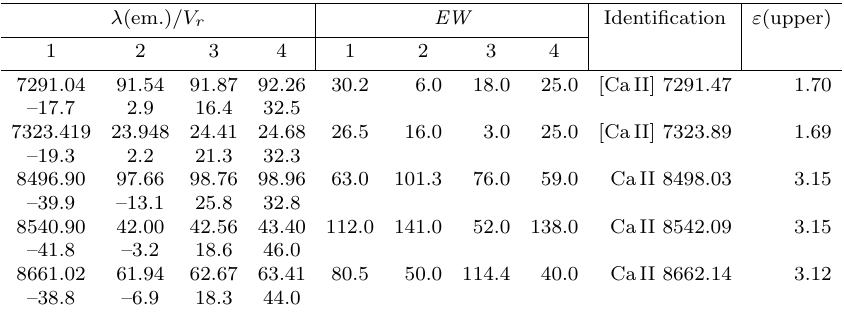
Table 5. The emission lines of Ca II and [Ca II] in the spectrum of υ Sgr. For each line 4 components are listed in two rows. In the (cid:12)rst row are the wavelengths and equivalent widths [pm], in the seecond row the radial velcity of the component [km s (cid:0) 1 ] is given. λ (em.) /V r EW Identi(cid:12)cation ε (upper)